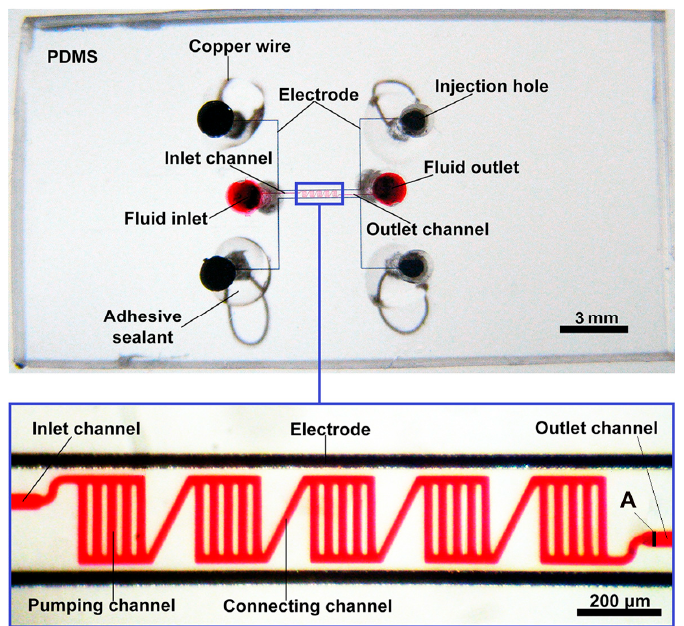
Figure 2. Photographs of the PDMS/glass chip for the five-stage EOF pump. The photo within the blue box shows the parallel pumping channels and the liquid metal electrodes of the pump. The pumping channels are filled with high red ink to mark their positions and shapes in the chip. In this pump, the PDMS gap is 20 μ m. The pumping channel is 20 μ m wide and 200 μ m long. The connecting channel is 20 μ m wide and 280 μ m long. The inlet/outlet channel is 40 μ m wide and 2 mm long. The electrode channel is 40 μ m wide. All channels are 20 μ m high. “A” represents the position of the pumping flow velocity measurement.